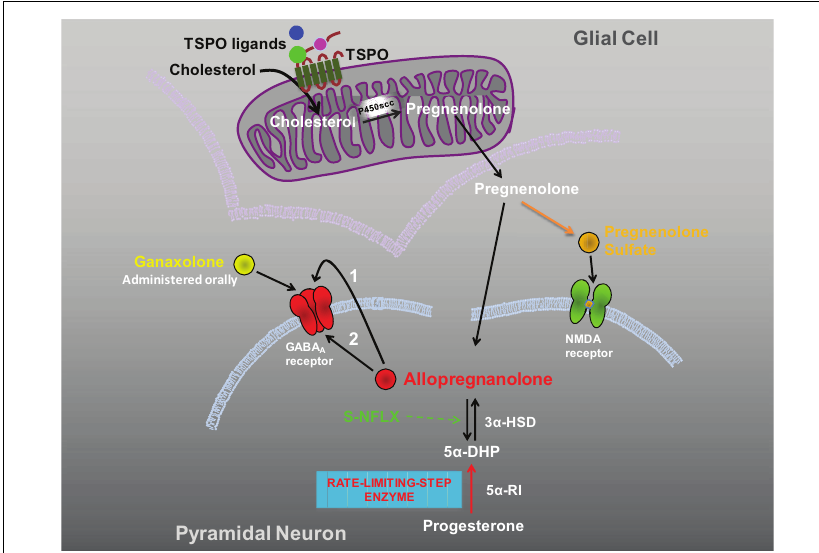
FIGURE 1 | Therapeutic strategies to increase neurosteroidogenesis and improve PTSD by enhancing GABAergic neurotransmission. Depicted are three strategies to improve PTSD symptoms by increasing corticolimbic allopregnanolone levels or by direct activation of GABA A receptors. (A) TSPO ligands induce an upstream regulation of neurosteroidogenesis by gating the entry of cholesterol into the inner mitochondrial membranes of glial cells, and its conversion into pregnenolone. Pregnenolone can then be taken up by pyramidal neurons (Costa and Guidotti, 1991) where a cascade of enzymatic processes takes place in the cytosol resulting in the production of allopregnanolone. Interestingly, pregnenolone can be further sulfated to pregnenolone sulfate, which has been described as both a positive NMDA receptor modulator (Kussius et al., 2009) and negative GABA the level of 3 α -HSD (Griffin and Mellon, 1999). Neurosteroidogenesis is not globally expressed in the brain but relies on rate-limiting step enzymes, which guard allopregnanolone availability